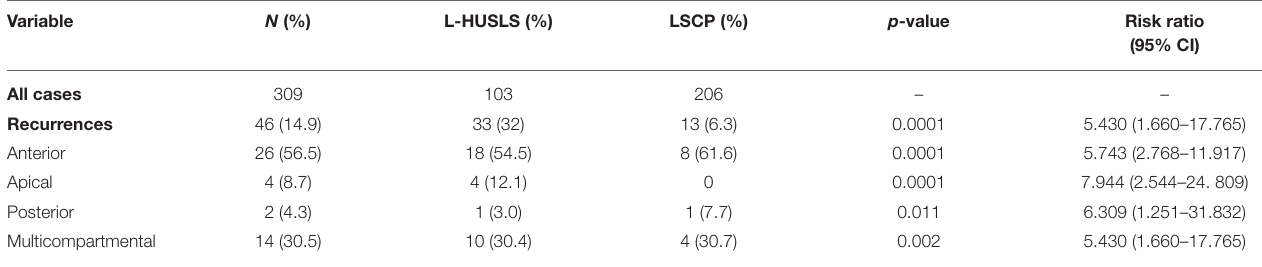
TABLE 5 | Pattern of recurrent prolapse according to surgical